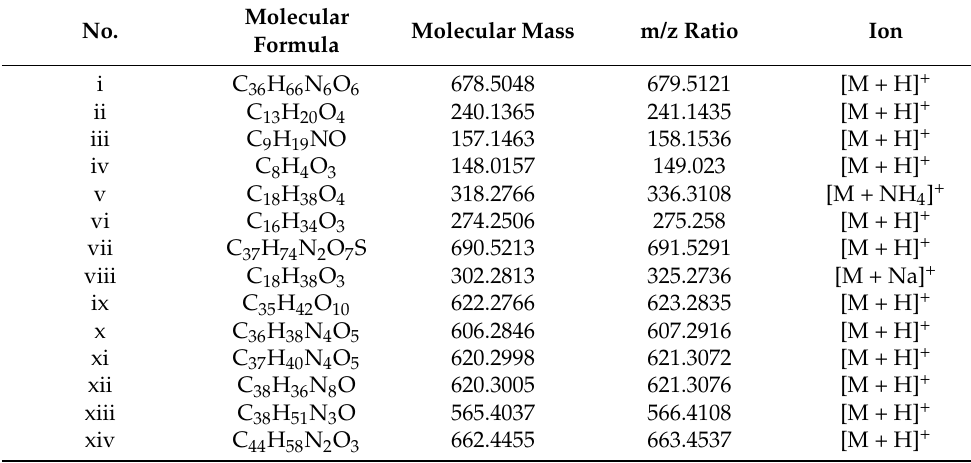
Table 4. Unknown compounds present in S. platensis ethanol